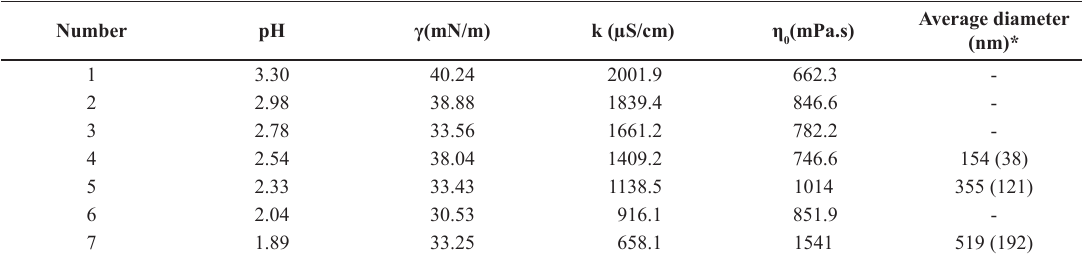
Figure 8. TGA thermal degradation of the polymer blend gelatin / PVP. Table 2. Values of solution properties and the average diameter of the fibers gelatin / PVP obtained by